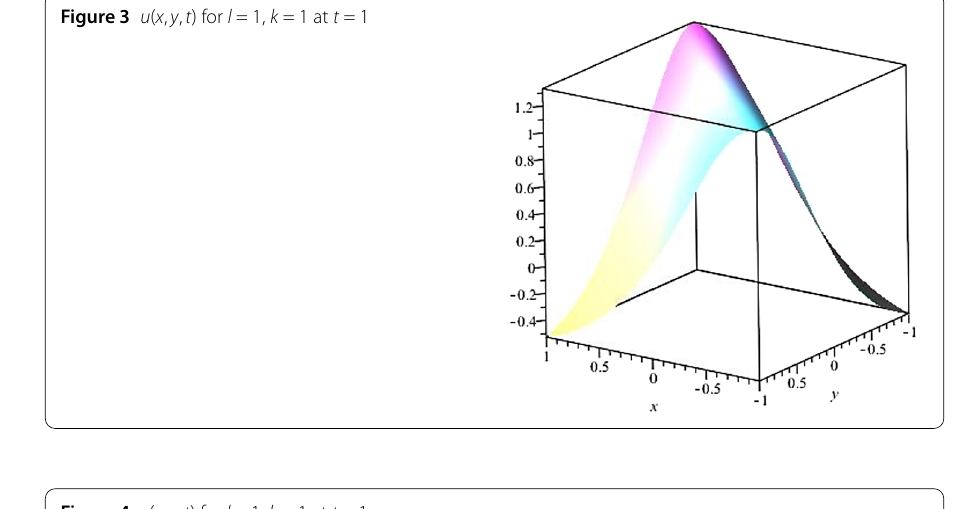
Figure 4 v ( x , y , t ) for l = 1, k = 1 at t =